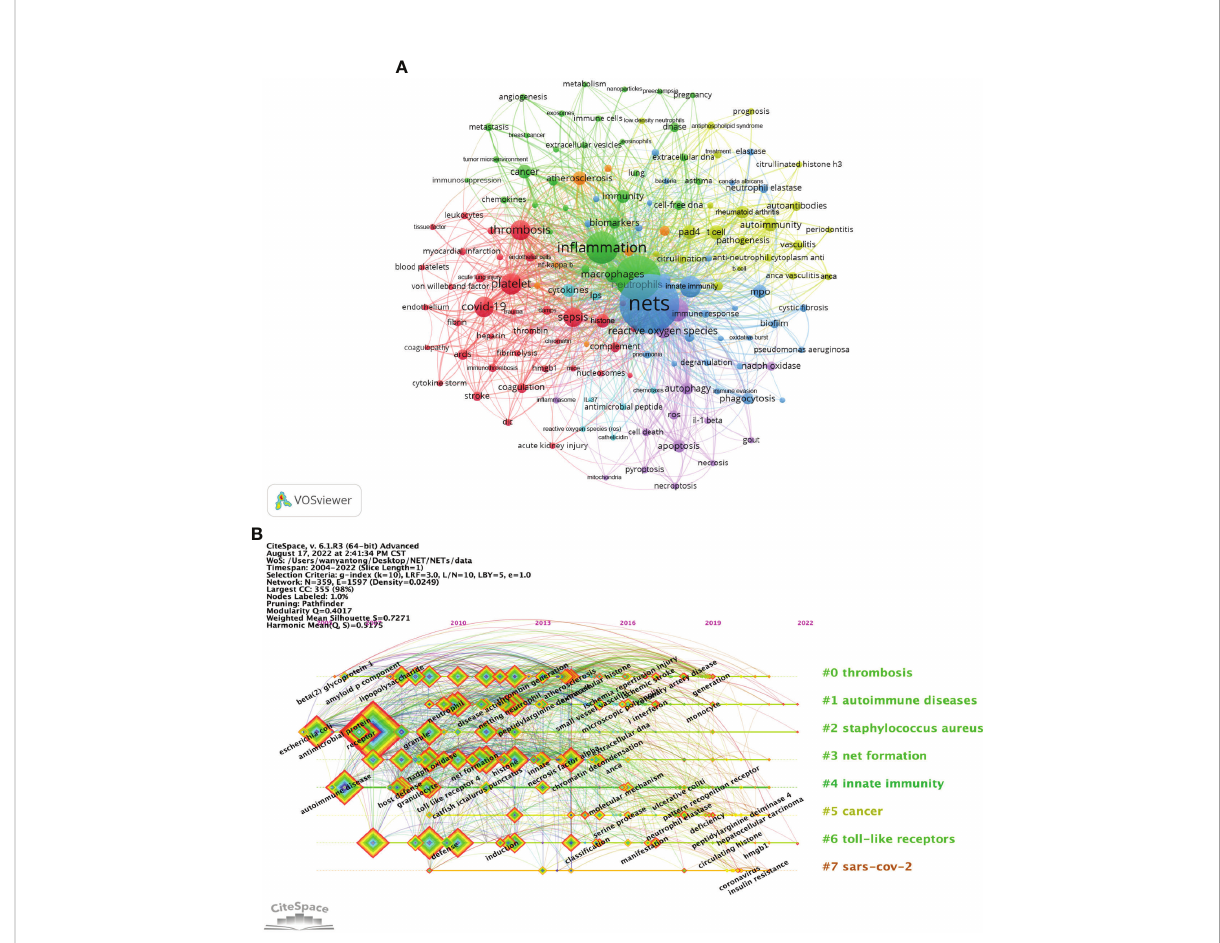
FIGURE 6 Analysis of NETs-related keyword. (A) Collaborative network visualization of keywords in VOSviewer. The fi gure shows the keywords with more than 15 occurrences. The nodes of different colors represent the keywords of different clusters, and the size of nodes indicates their frequency. (B) Timeline view of keywords. Each horizontal line represents a cluster. The smaller the number is, the larger the cluster, with #0 being the largest cluster. Nodes size re fl ects co-citation frequency, and the links between nodes indicate co-citation relationships. Nodes occurrence year is the time when they were fi rst